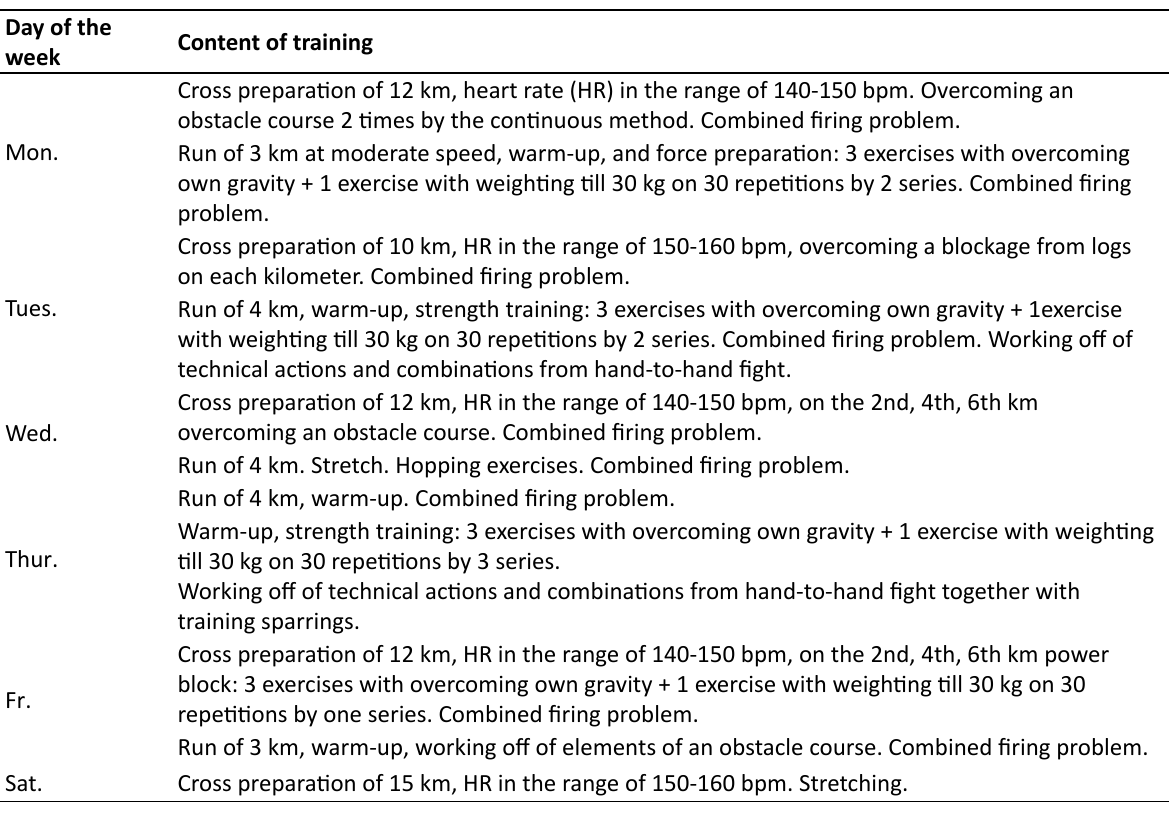
Table 1. The program of training of cadets for the qualified examination on the right to wear the beret with honors Day of the Content of week